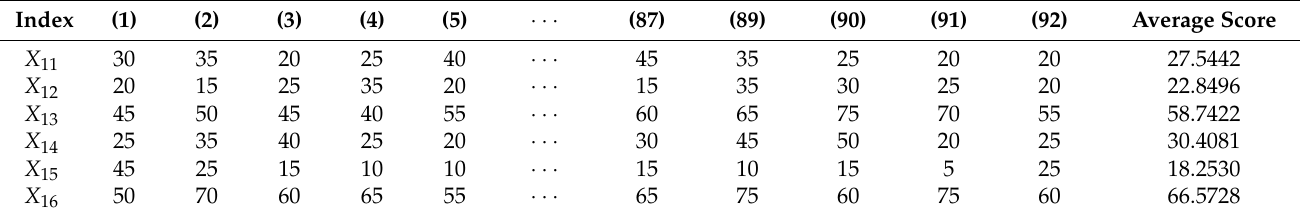
Table A2. Scores of secondary